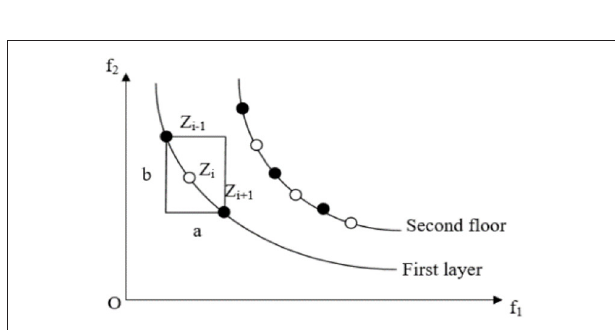
FIGURE 1 | Calculation method of individual crowded distance in the NSGA-II algorithm.